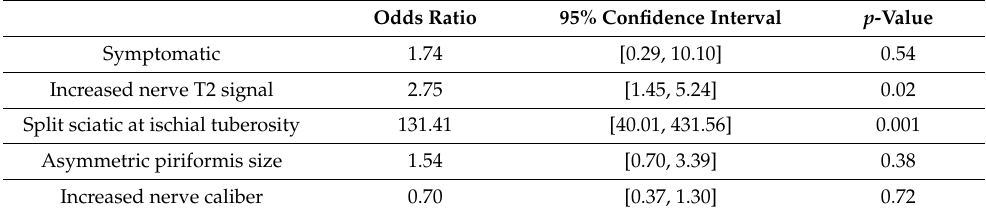
Table 4. Odds ratio and 95% confidence interval of imaging characteristics as predictors, and anatomical variant as outcome.